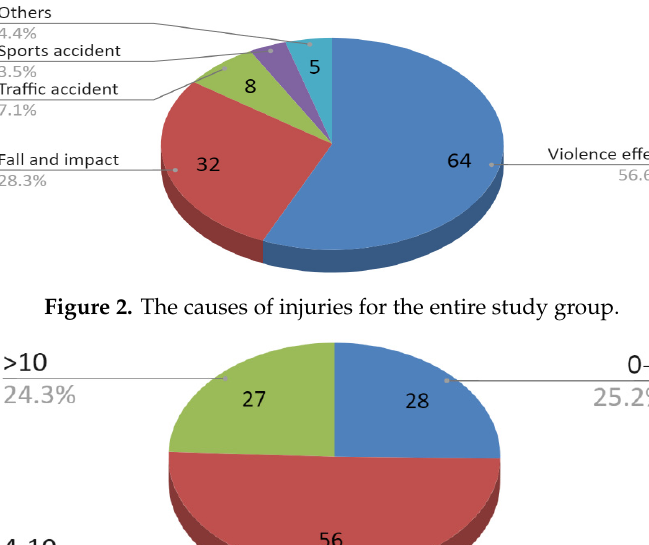
Figure 1. Classification of all patients in accordance to age range.